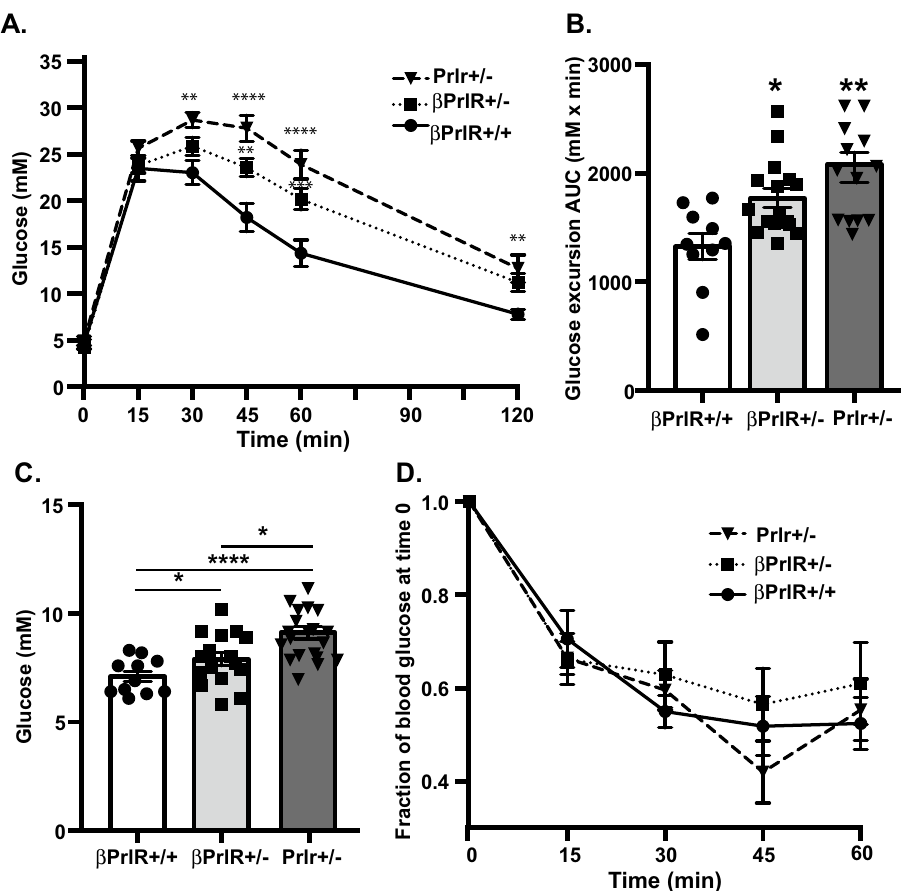
Figure 2. βPrlR +/− and Prlr +/− mice are glucose intolerant during pregnancy. ( A ) Glucose excursion during an intraperitoneal glucose tolerance test. ( B ) Integrated area under the curve (AUC) of glucose excursion during an 120-min IPGTT. ( C ) Random non-fasting blood glucose. ( D ) Glucose excursion during an intraperitoneal insulin tolerance. Blood glucose was expressed as a fraction of the blood glucose at time 0. “*” = p < 0.05, “**” = p < 0.01, and “****” = p < 0.001 in comparison to the wild type βPrlR +/+ mice by 2 way ANOVA ( A , D ) and 1 way ANOVA ( B , C ) with Tukey’s multiple comparisons tests. n = 3–19 mice per genotype.